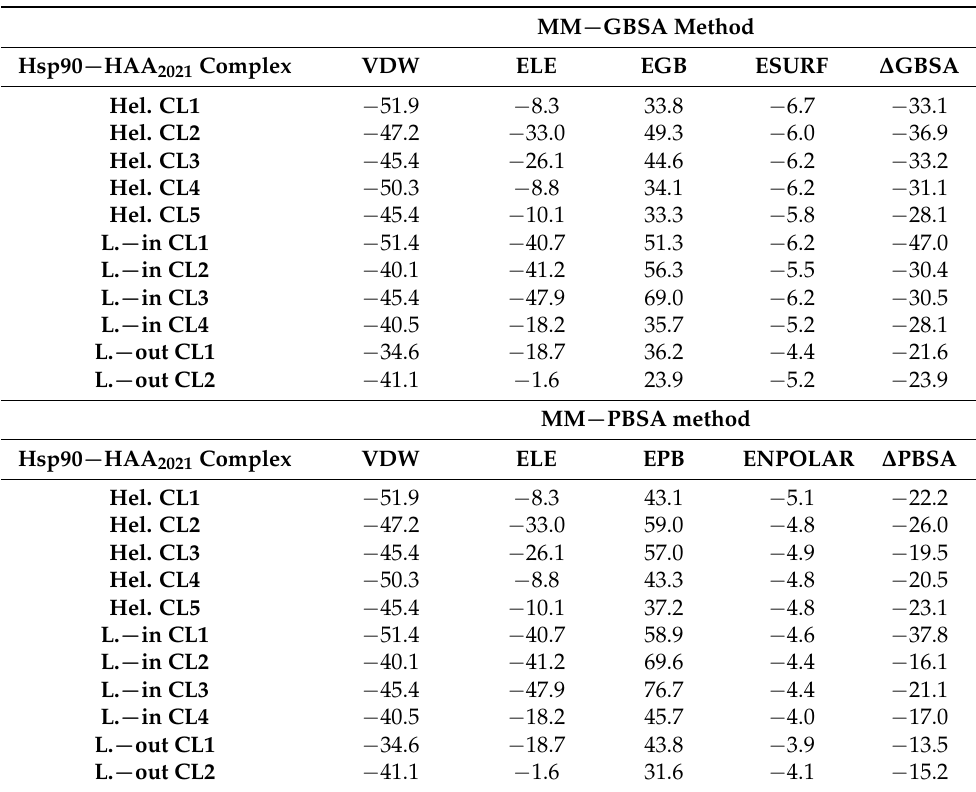
Table 4. MM-GBSA and MM-PBSA results for the eleven different Hsp90-HAA 2021 complexes. ∆ GBSA and ∆ PBSA are the sum of the van der Waals (VDW), electrostatic (ELE), as well as po- lar (EGB/EPB) and non-polar (ESURF/ENPOLAR) solvation free energy. Data are expressed as kcal · mol − 1